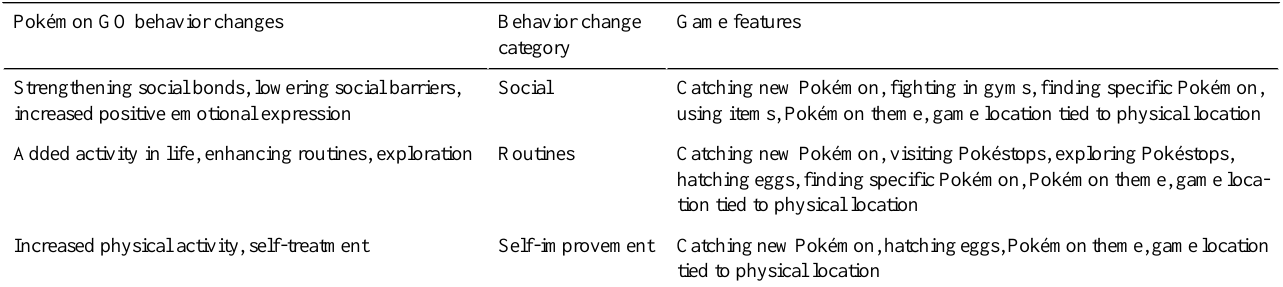
Table 3. Behavior change